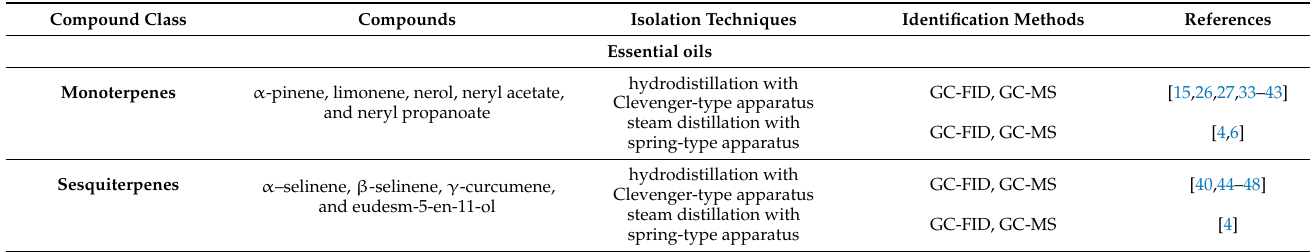
Table 1. Isolation techniques for obtaining Helichrysum italicum extracts and essential oils enriched with bioactive